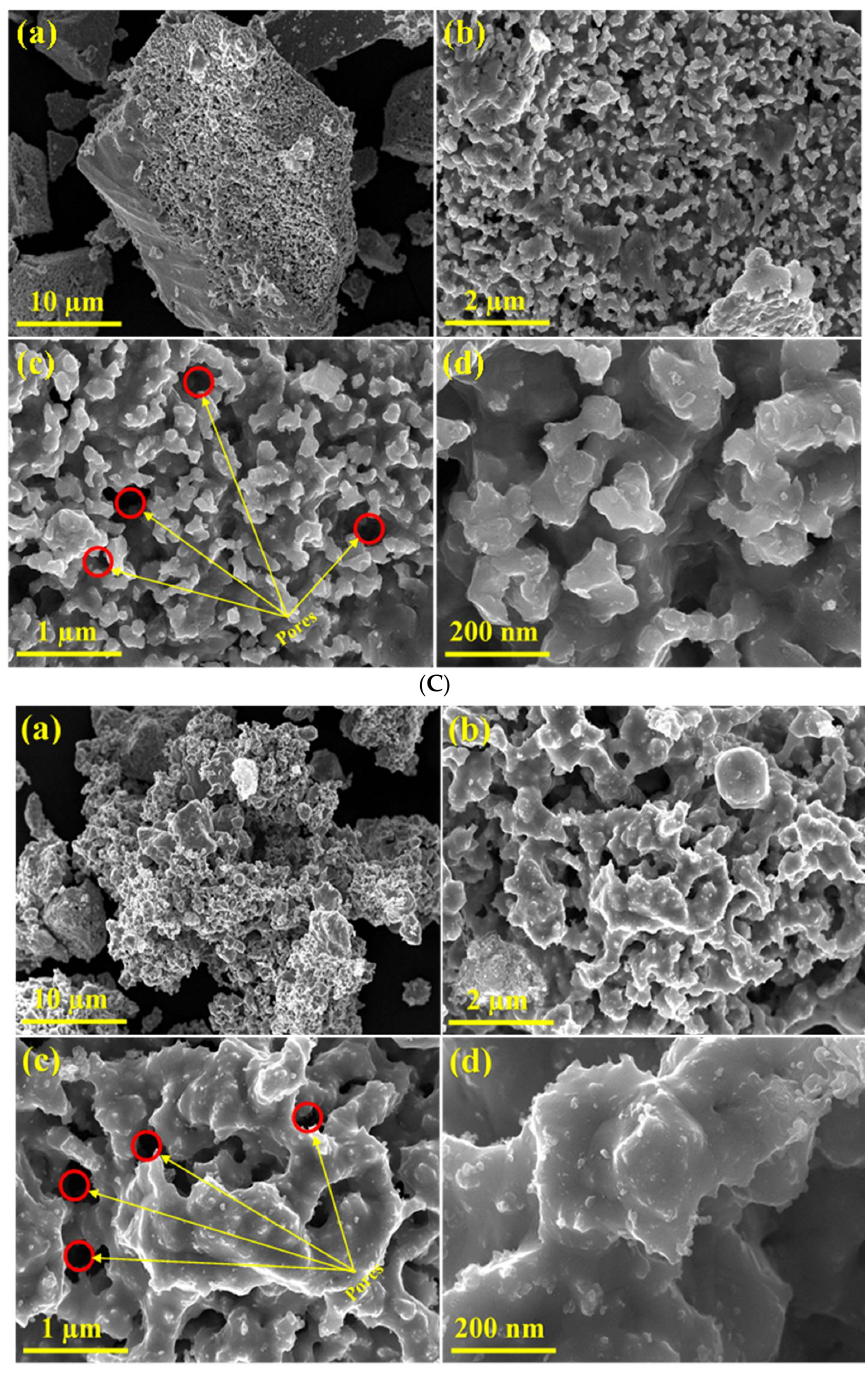
Figure 8. FESEM images of the reduced ( A ) Ni, ( B ) Ni-Co, ( C ) Ni-Fe, and ( D ) Ni-Cu.